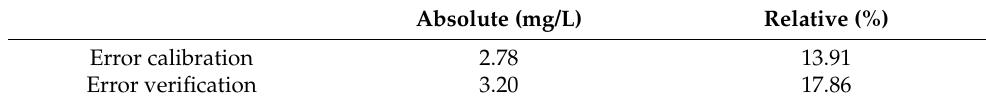
Figure 19. Observed vs. predicted Equation (7) improved.